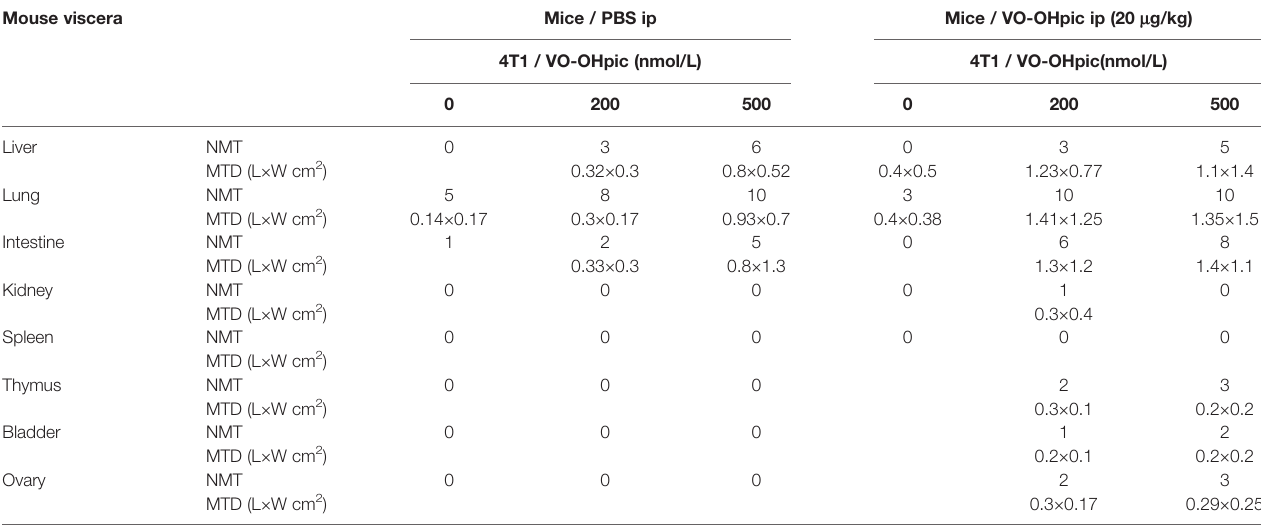
TABLE 1 | Organic metastases of PTEN-inhibited and -uninhibited B16 cells in wild and PTEN-de fi cient Balb/c mice. Mouse